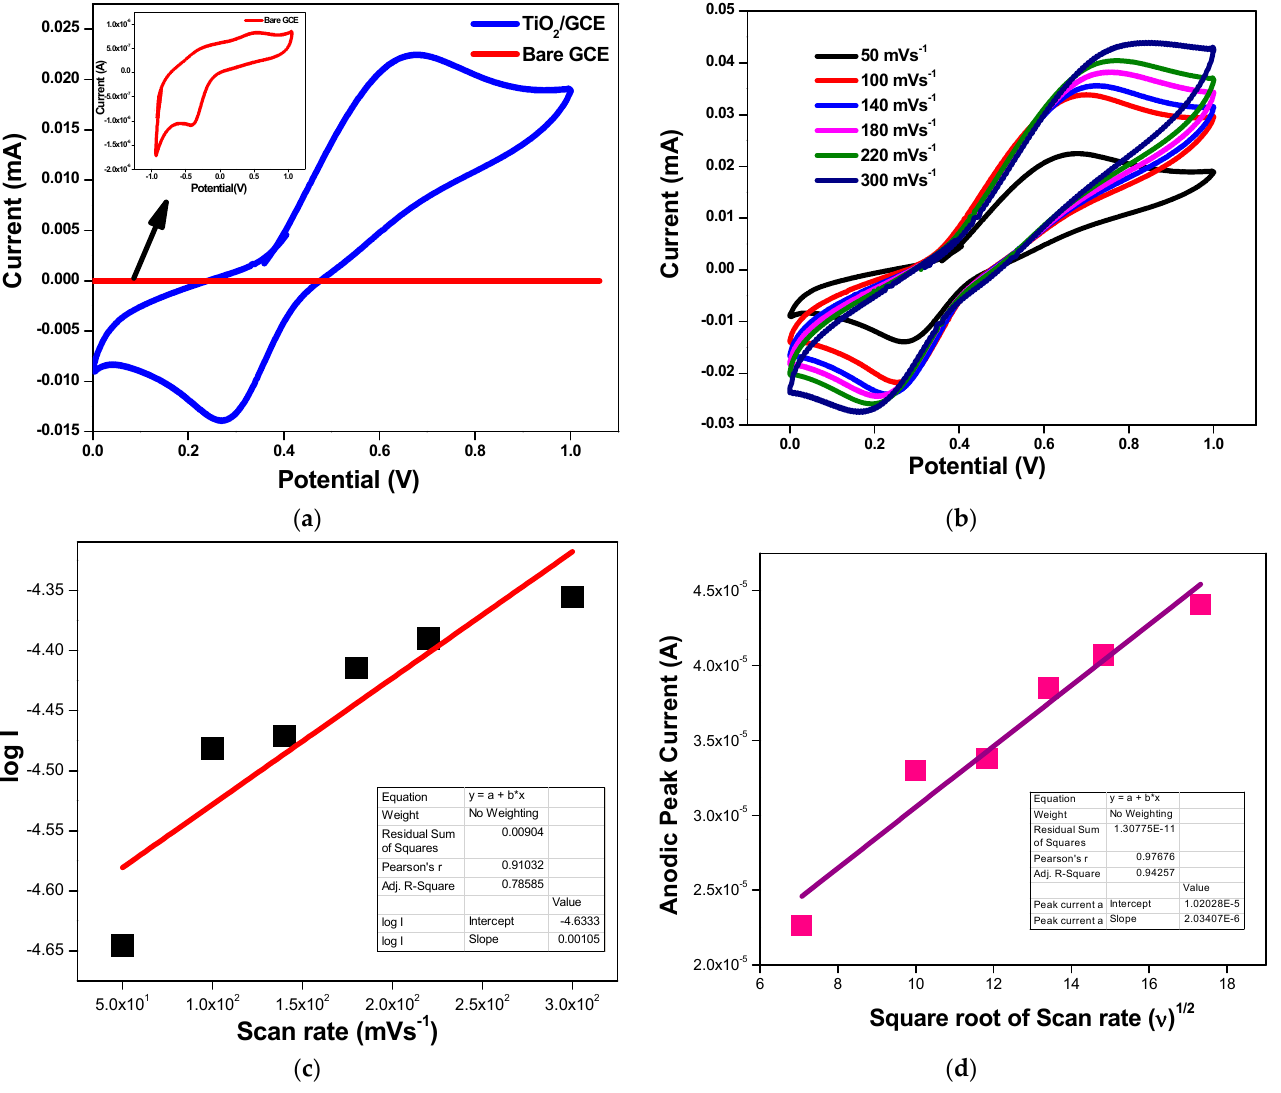
Figure 9. ( a ) Comparison of CVs; ( b ) variation of scan rates; ( c ) plot of log I vs. scan rate; ( d ) anodic peak current vs. ν ½.